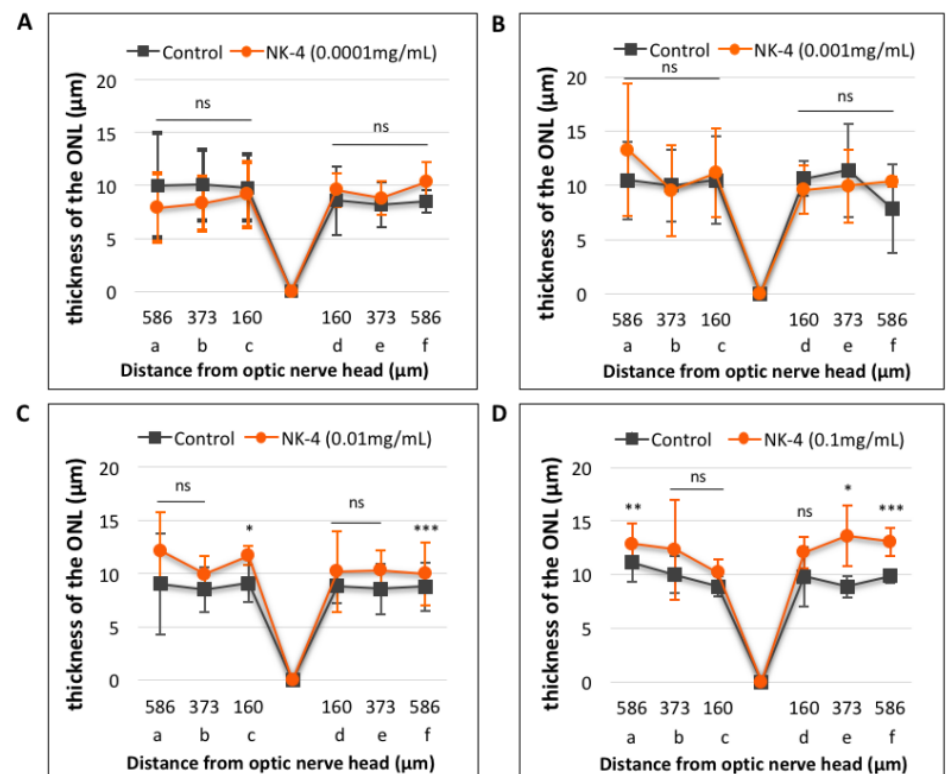
Figure 5. Quantitative analysis of the thickness of the ONL in retinal sections. ( A ): NK-4 (0.0001 mg/mL)-injected retinas vs. control groups; ( B ): NK-4 (0.001 mg/mL)-injected retinas vs. control groups; ( C ): NK-4 (0.01 mg/mL)-injected retinas vs. control groups; ( D ): NK-4 (0.1 mg/mL)-injected retinas vs. control groups. The thickness in the ONL: NK-4 (0.1 mg/mL) vs. control vehicle-injected eyes (site a: p = 0.00753, site e: p = 0.01125, site f: p = 0.00067, Student’s t -test). The thickness in the ONL: NK-4 (0.01 mg/mL) vs. control vehicle-injected eyes (site c: p = 0.00344, site f: p = 0.00055, Student’s t -test). *: p < 0.05, **: p < 0.01, ***: p < 0.001.